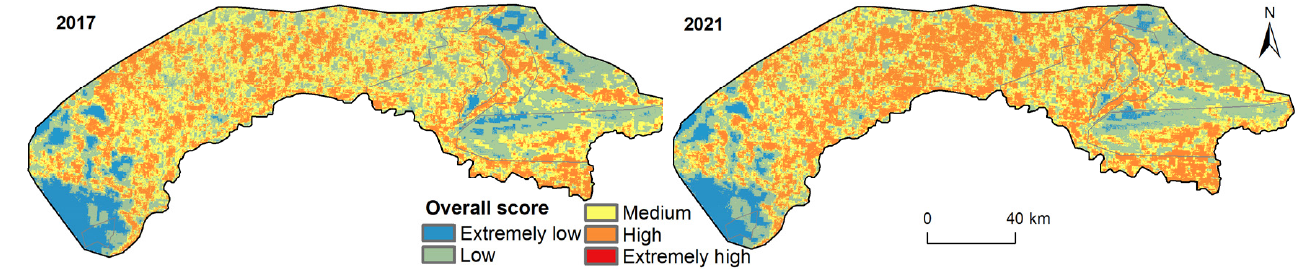
Figure 3. Ecological status rating map of the Wuliangsuhai watershed.